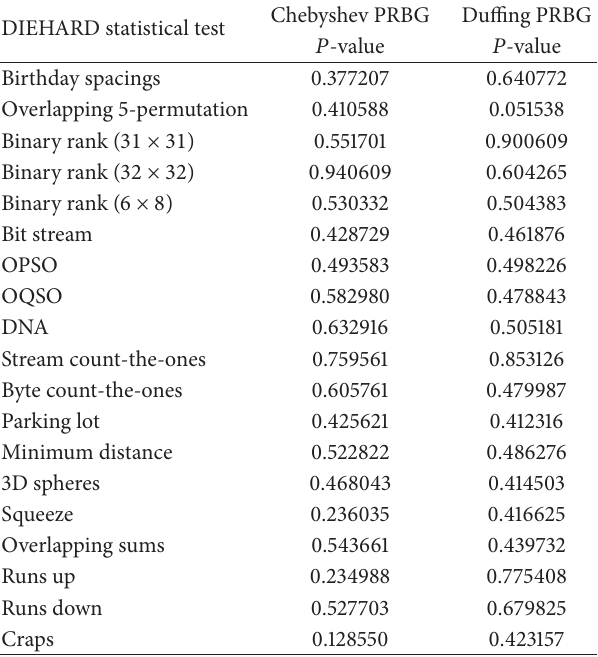
Table 2: DIEHARD statistical test results for two 80 million bits sequences generated by the proposed Chebyshev polynomial based pseudorandombitgeneratorandDuffingmapbasedpseudorandom bit